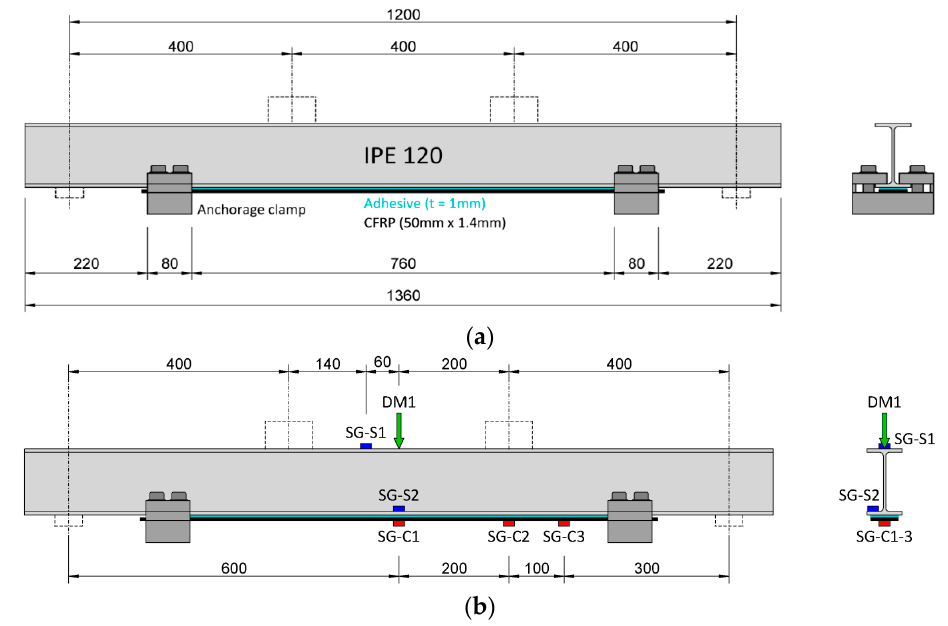
Figure 8. Cont. Figure 8. Cont.